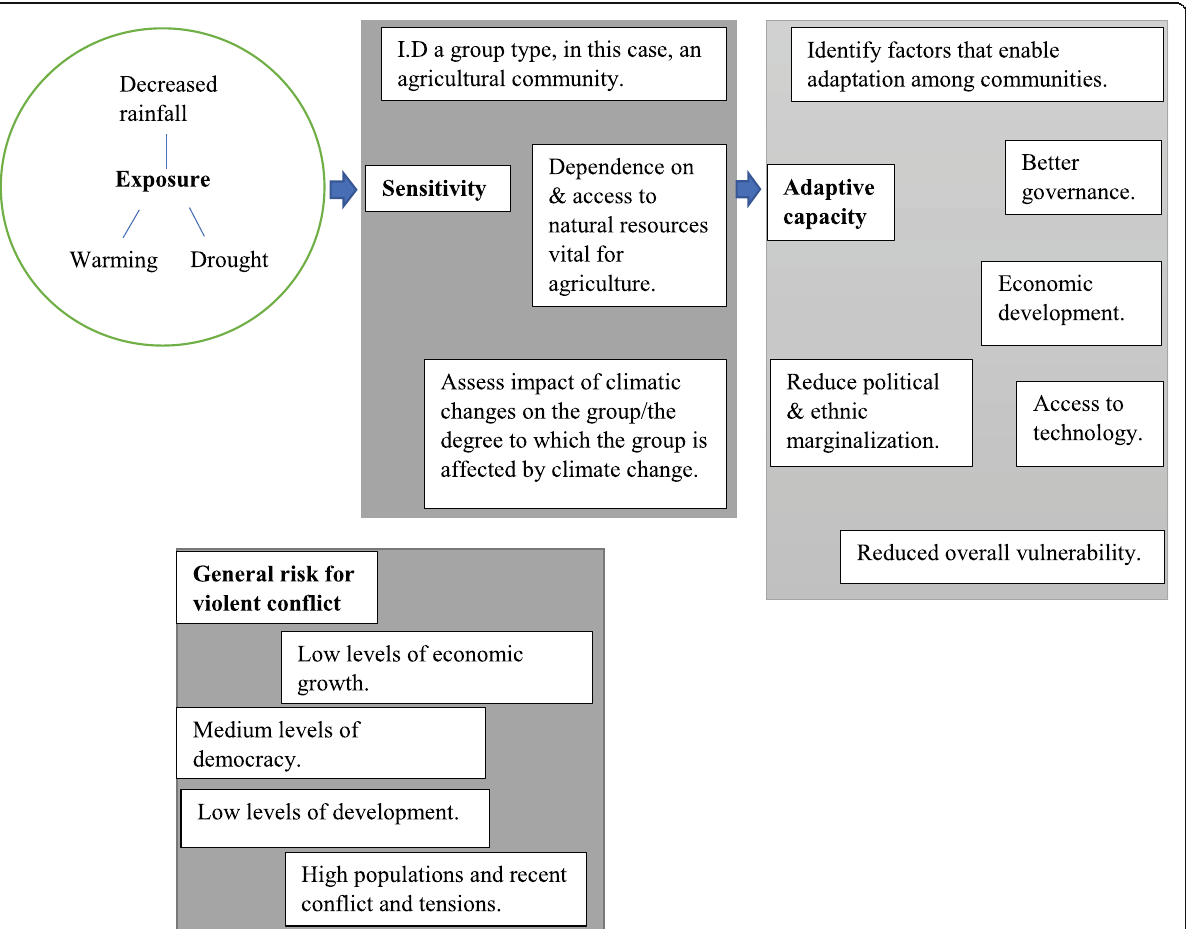
Fig. 5 The Vulnerability Model. represents a visualization of the ‘ vulnerability pathway ’ which serves to identify factors which can, if addressed, reduce the risk of violent conflict through identifying what influences the adaptation needs of an agricultural